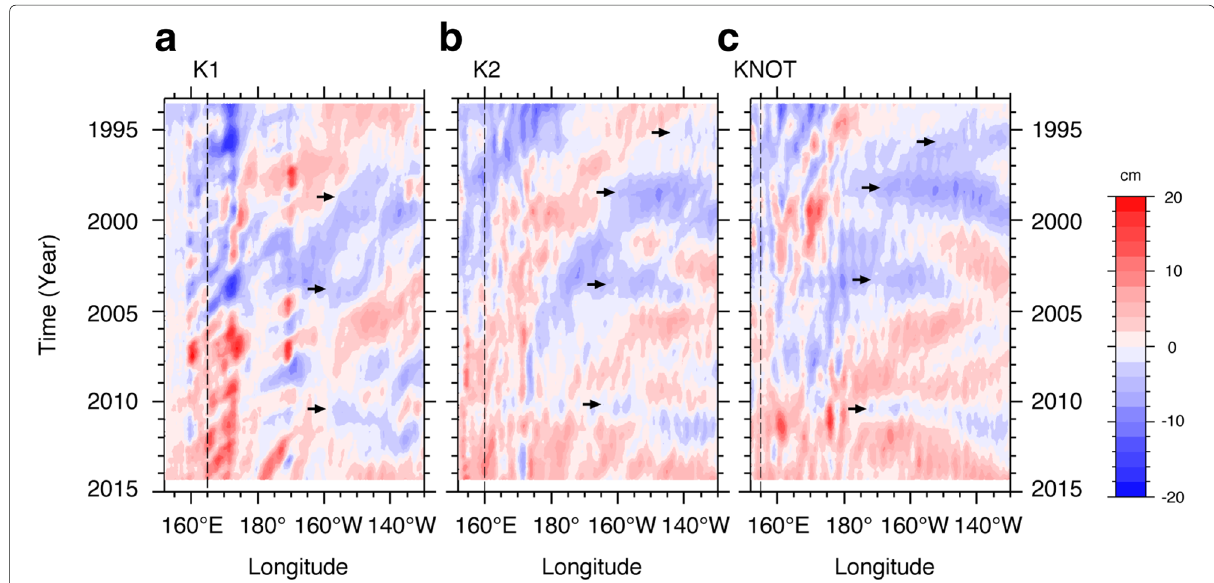
Fig. 9 Hovmöller (longitude-time) diagrams of the altimetric SSH anomalies (cm) at the latitudes of stations a K1 (51° N), b K2 (47° N), and c KNOT (44° N). Smoothing was performed using a 15-month running mean filter. The vertical dotted lines in panels ( a ), ( b ), and ( c ) indicate the longitudes of K1, K2, and KNOT, respectively. Arrows show El Niño-related SSH